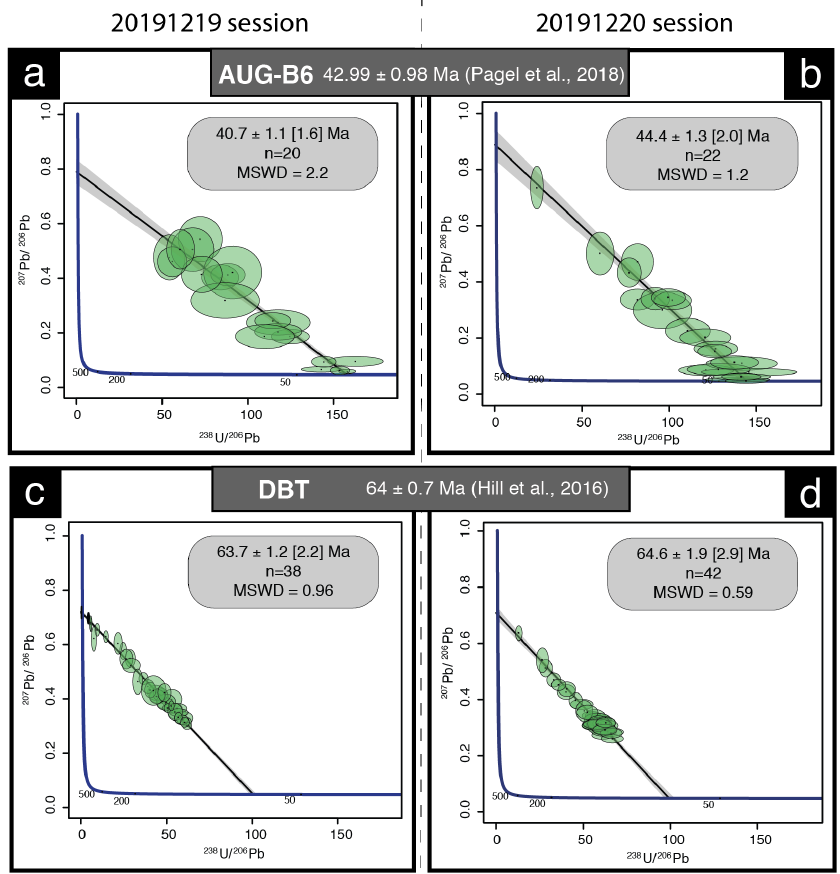
Figure A2. Tera–Wasserburg diagrams of secondary calcite reference materials. (a, b) Tera–Wasserburg diagrams displaying corrected ages for the calcite of the Gondrecourt graben AUG-B6 measured during the two analytical sessions. (c, d) Tera–Wasserburg diagram displaying the Duff Brown Tank corrected ages measured during the two analytical sessions.